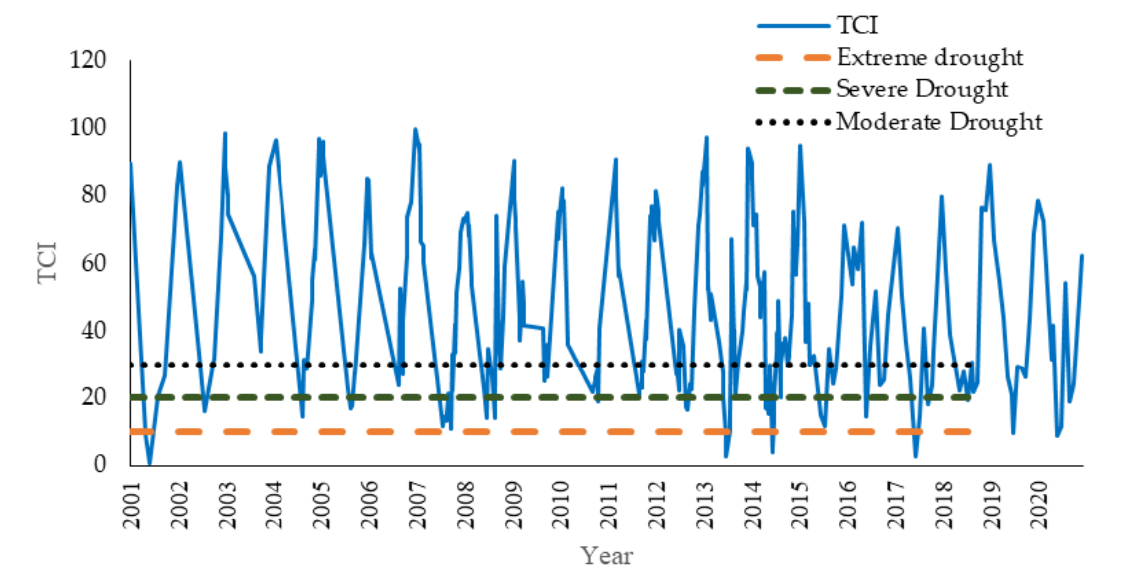
Figure 7 . Time series plot of TCI in Al-Lith Watershed extracted using Google Earth Engine and Landsat Satellite datasets.